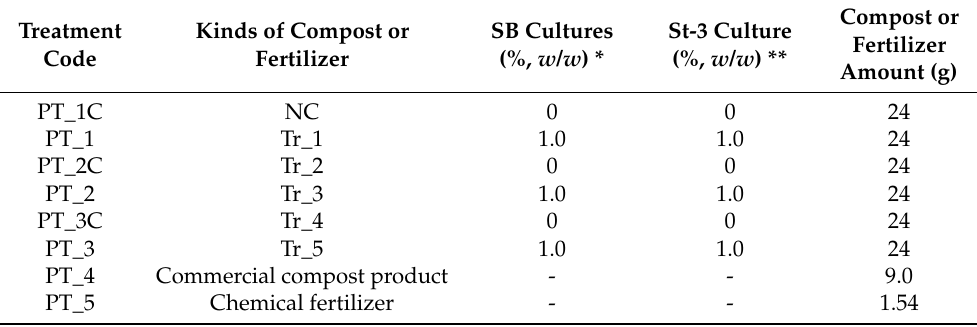
Table 2. Conditions for pepper plants for the test of growth and antioxidant production by treatment of functional compost in